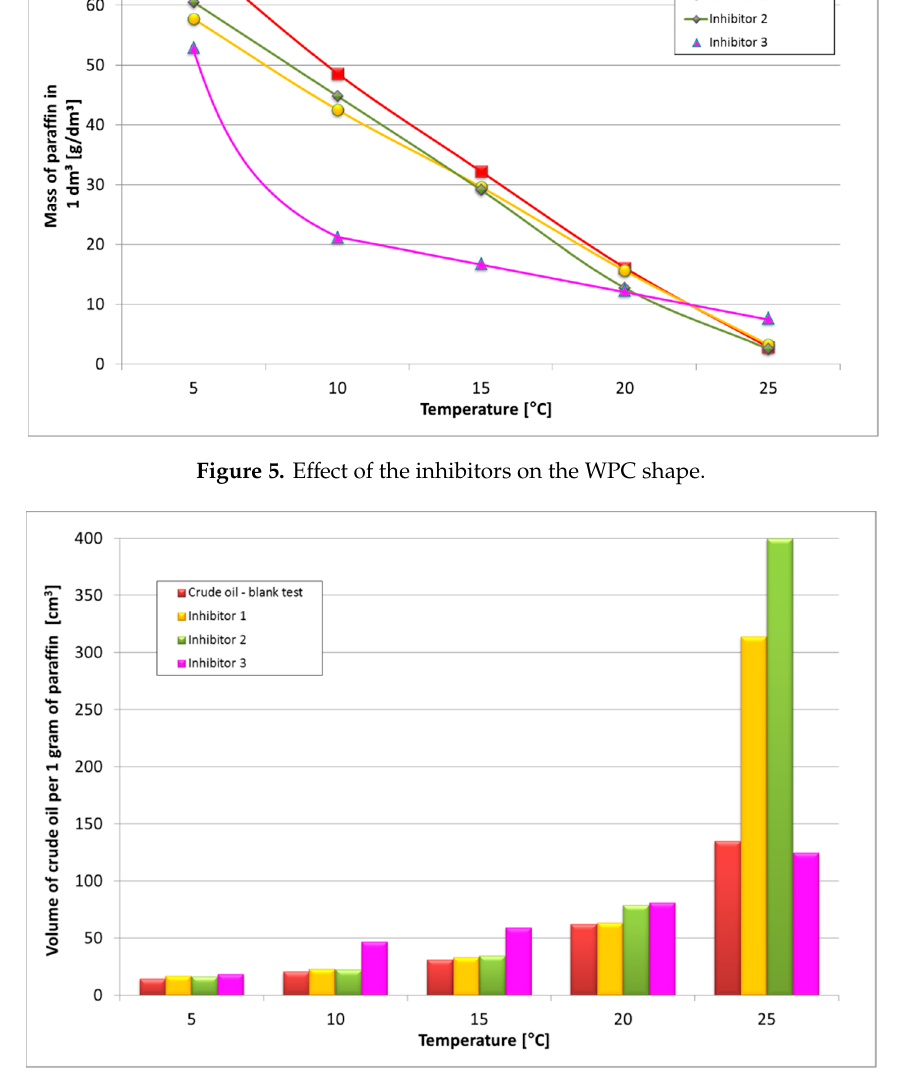
Figure 6. Effect of the inhibitors on the volume of oil sample needed for deposition of 1 g of the paraffins.